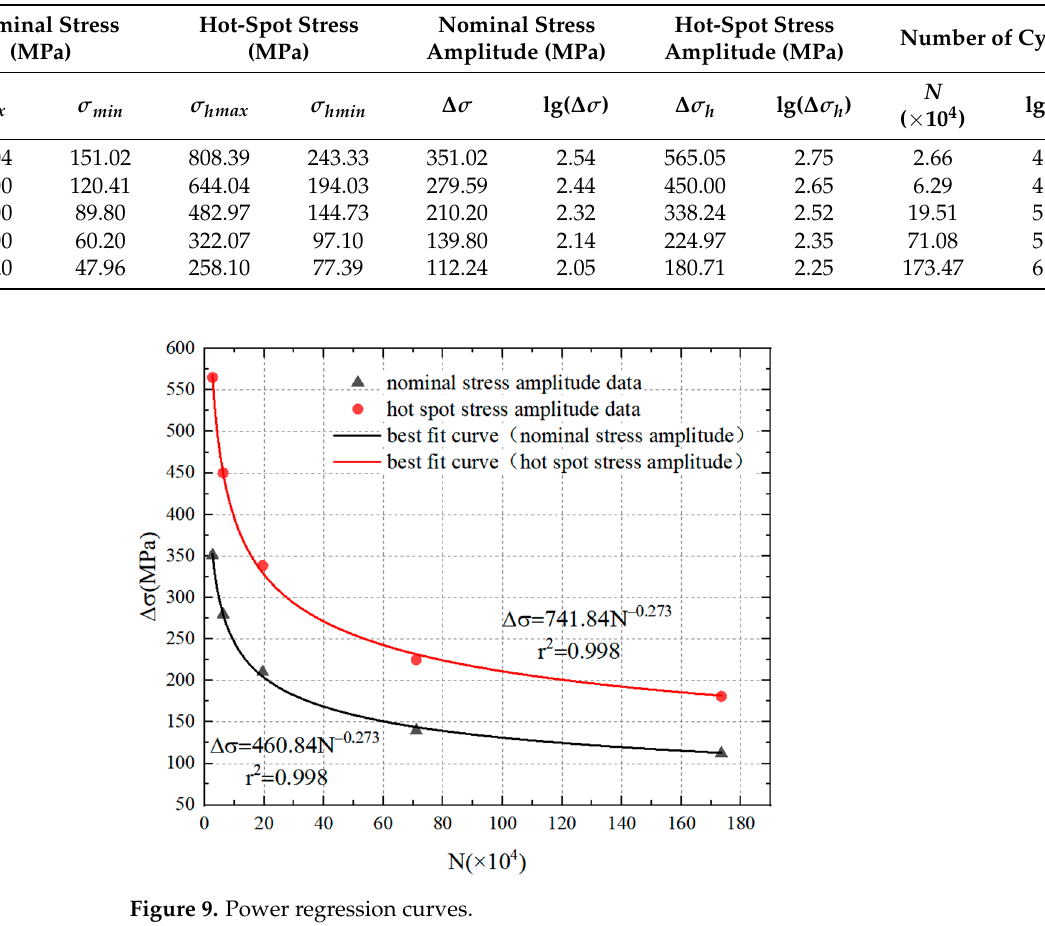
Table 3. Hot ‐ spot stress and hot ‐ spot stress amplitude of M20 torque ‐ shear HSBs without preten ‐ sion.